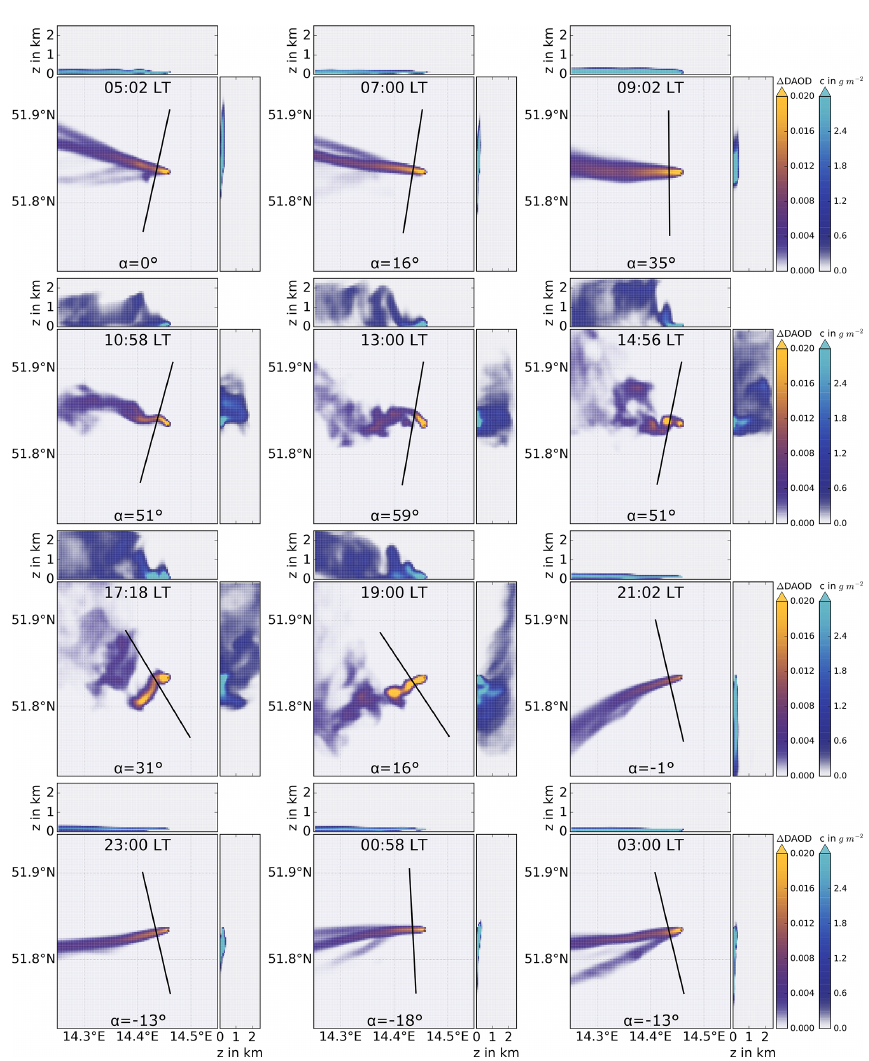
Figure A2. Exemplary snapshots of simulated DAOD. Exemplary snapshots of simulated plume and virtual flight track. At the respective tops, local time is given in Central European summer time (CEST, i.e., UTC + 2), and at the bottom α denotes the local solar altitude. The daily solar irradiation causes a deep, convective boundary layer with turbulent plume dispersion within. In the nocturnal absence of solar irradiation, the boundary layer shrinks, leading to narrow, homogeneous plume dispersion within a laminar flow. Every 2min a virtual measurement is performed yielding 60 measurements within a time frame of 2h. One representative snapshot within the 2h time frame is shown. Some snapshots show disjointed exhaust plumes. This is due to vertical wind shearing and the resulting different vertical advection